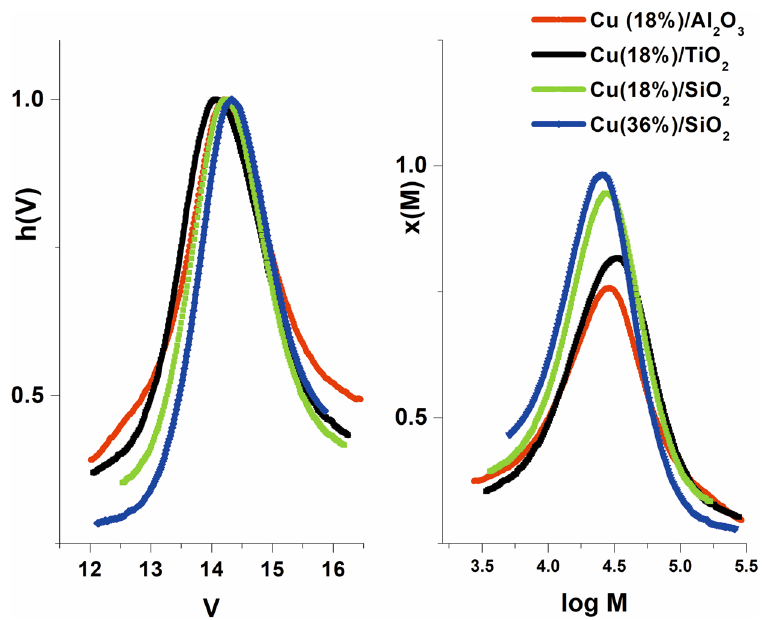
Figure 4. GPC traces for poly(butyl acrylate) obtained using different catalysts using Me 6 TREN